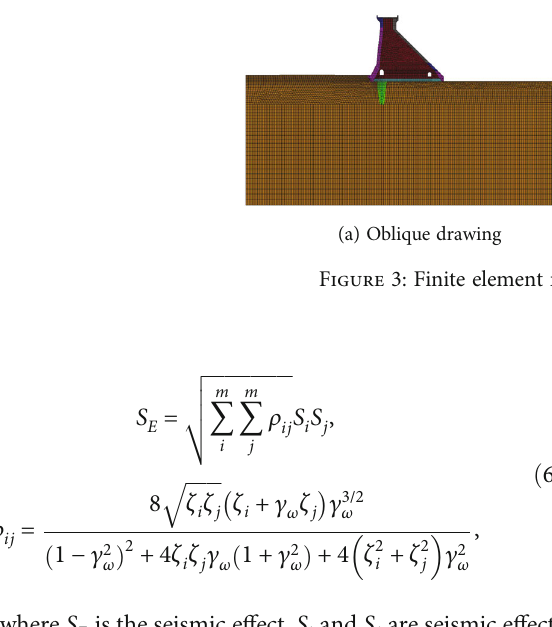
Figure 4: Thin layer units between sluice opening and closing rooms and between highway